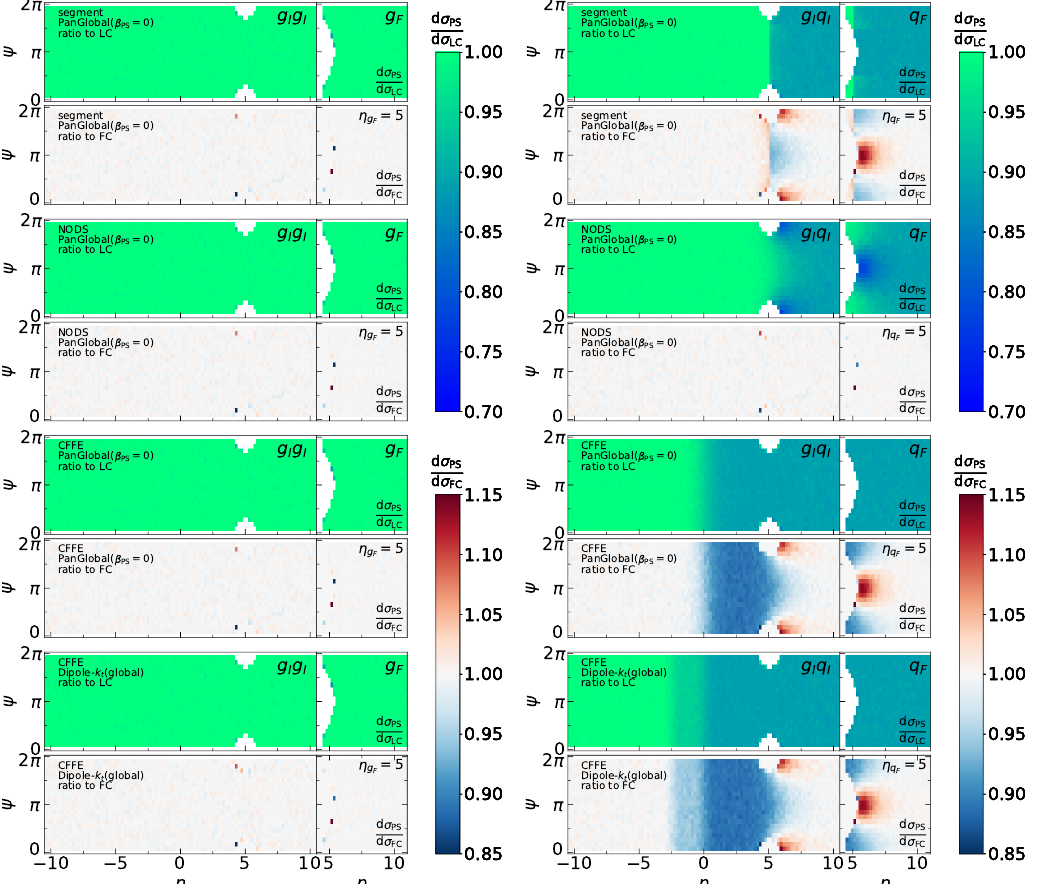
Figure 9. Same as figure 8 but for emission of a soft gluon from g I g I → Hg F (left) and g I q I → Hq F (right)